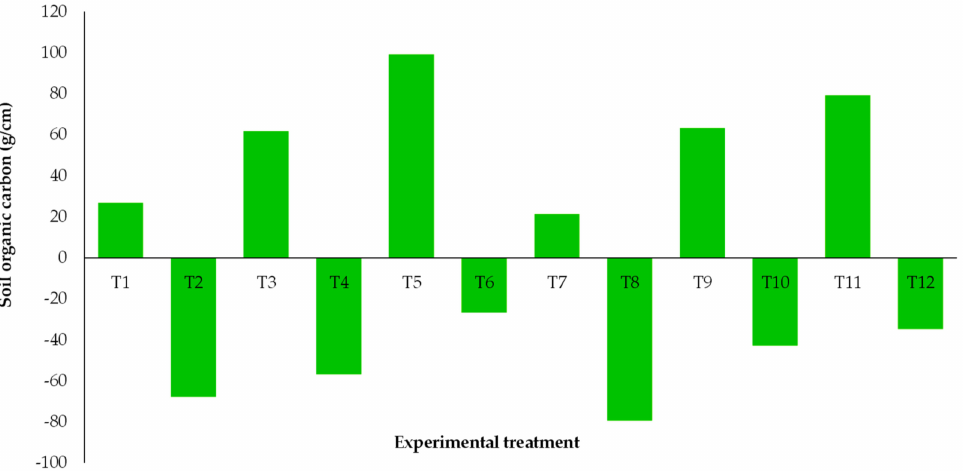
Figure 3. Yearly SOC change rate (g of cm − 2 year − 1 ) under alternative cropping systems and precision land leveling practices.